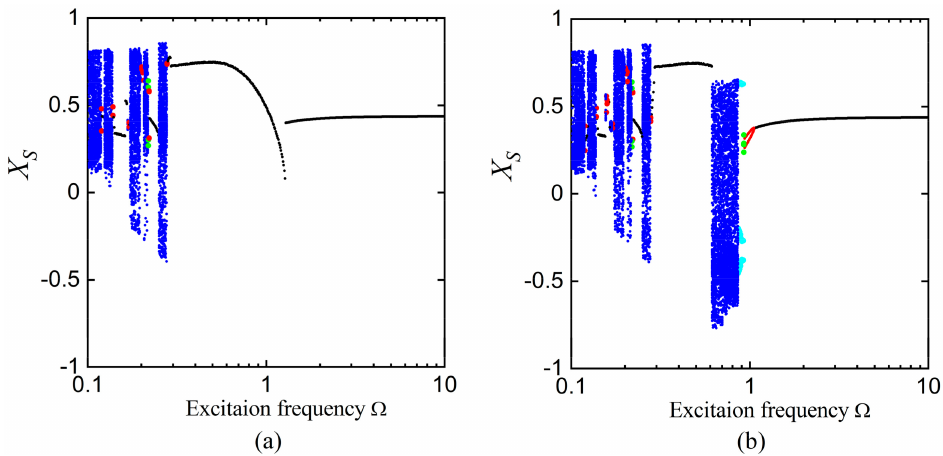
Figure 7. Possible chaotic motions of the double–well potential system ξ = 0.02, α = − 0.55, β = 2, F 0 = 0.05. ( a ) Sweeping from low to high frequencies and ( b ) sweeping from high to low frequencies. Period–1 (black), period–2 (red), period–3 (cyan), period–4 (green), and chaotic motion